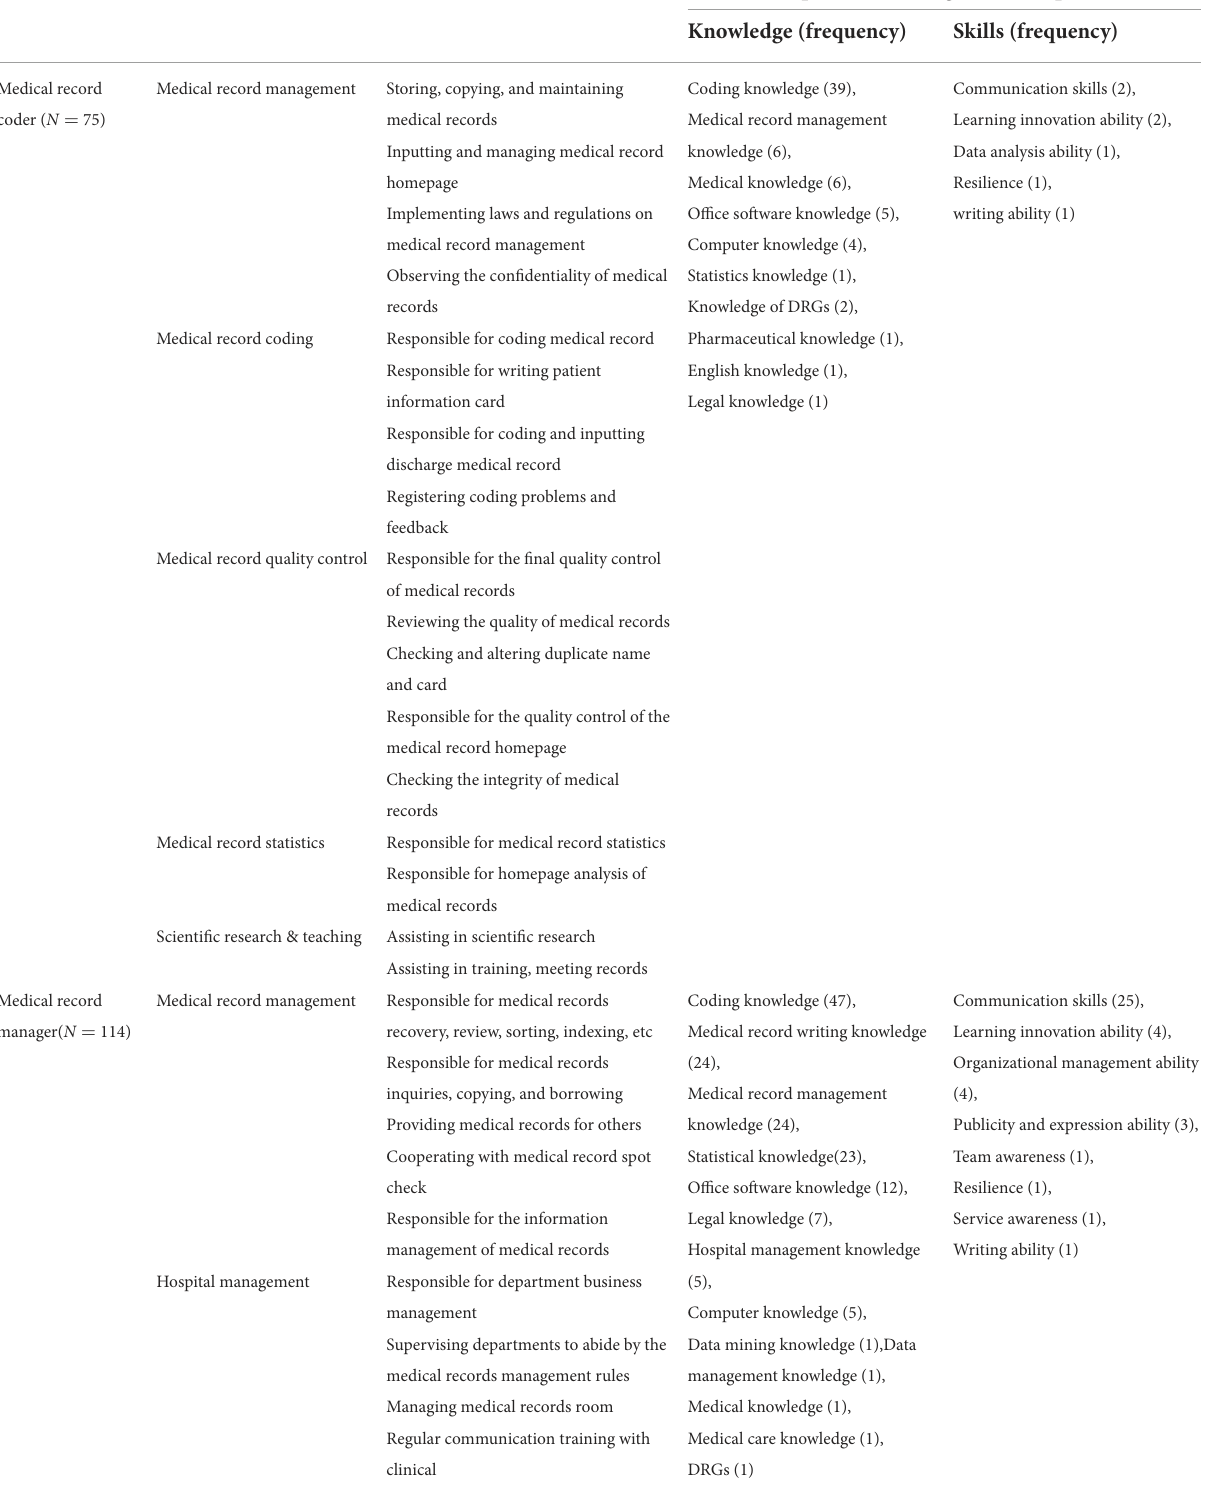
TABLE 3 Job analysis of typical